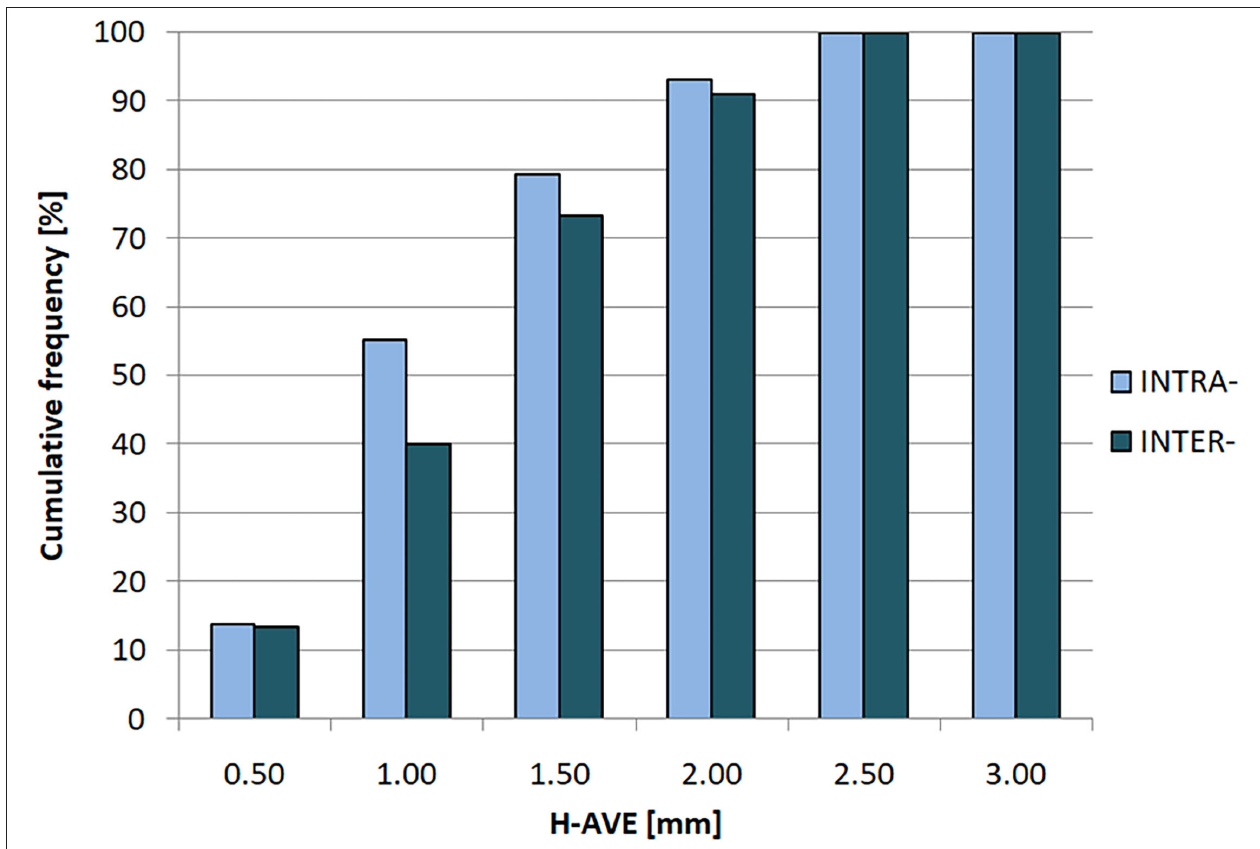
FIGURE 4 | Cumulative histogram of H-AVE (Hausdorff average distance) for intra- (light/blue) and inter-observer (dark/aquamarine)